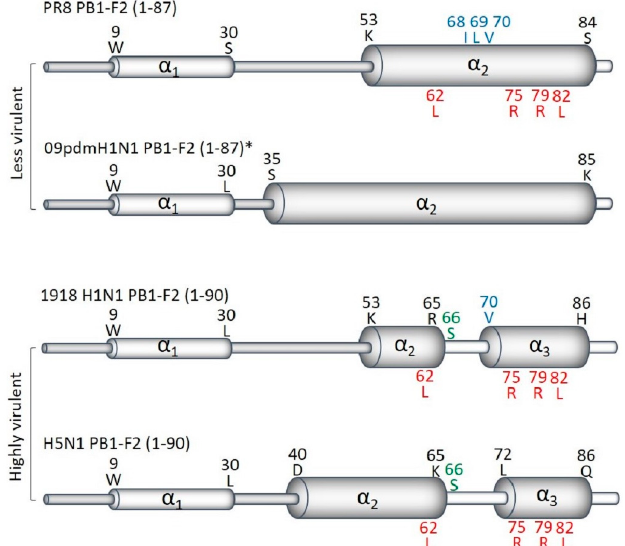
Figure 1. Secondary structure of PB1-F2 C-terminus differ between highly and less virulent viruses. (Adapted from Solbak et al. 2013 [16]). The overall predicted secondary structures of full-length PB1-F2 of PR8, 2009pdmH1N1 *, 1918 H1N1 and HPAIV H5N1 are shown. Regions with the best-defined α -helical structure in the C-terminal are denoted with broad cylinders, whereas regions with lesser-defined α -helical structure in the N-terminals appear as thin cylinders. PB1-F2 of less virulent strains have one longer α -helix, while the highly virulent viruses contain two α -helices in its C-terminus. The positions and residues of virulent sequence variants of PB1-F2 are shown in green (N66S), blue (the cytotoxic motif), and red (the inflammatory motif). * All 2009pdmH1N1 express PB1-F2 of only 11 amino acids. The structure shown was predicted for full-length PB1-F2, restored by mutating pre-mature stops codons.